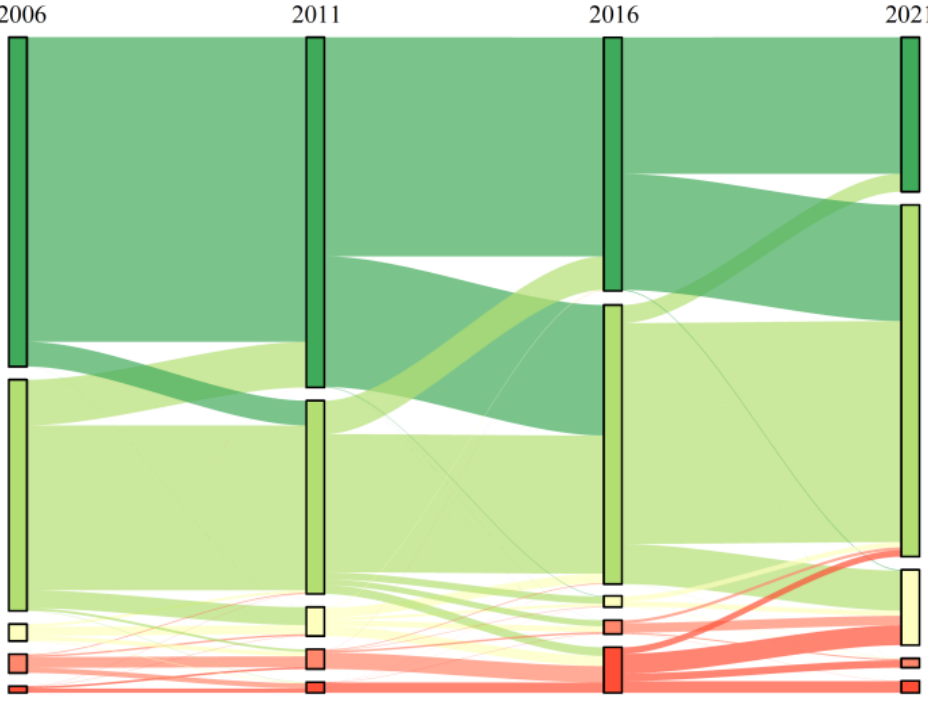
Figure 6. Changes in ecological quality from 2006 to 2021.